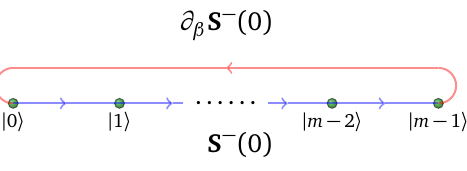
Figure 2: Combined periodic action of S − ( 0 ) (in blue) and ∂ β S − ( 0 ) (in red) on the auxiliary degree of freedom. Operator S − ( β ) is one of the matrices that encode the coefficients in the operator-basis expansion (31) of the dynamical symmetries Y ( λ ) . Since it is coupled to the spin raising matrix s + , its m -step periodic action connecting the state | 0 〉 to itself produces a surplus of m operators s + acting on different sites in the spin